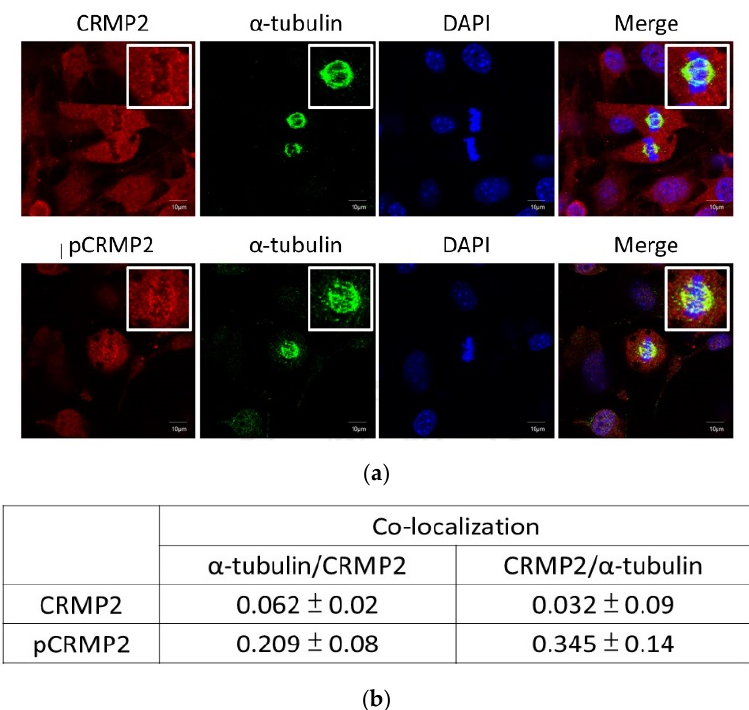
Figure 3. CRMP2 expression profile in mitotic clonal expansion phase. ( a ) Cells were induced into differentiation by MDI cocktail and subjected to immunostaining at 22 hr post induction. Images were obtained with Zeiss LSM700 confocal microscope using 63X objective lens, scale bar = 10 µ m. ( b ) Quantification of confocal microscopic results in ( a ). Data are presented as means ± SEM of about 50 cells from different fields.